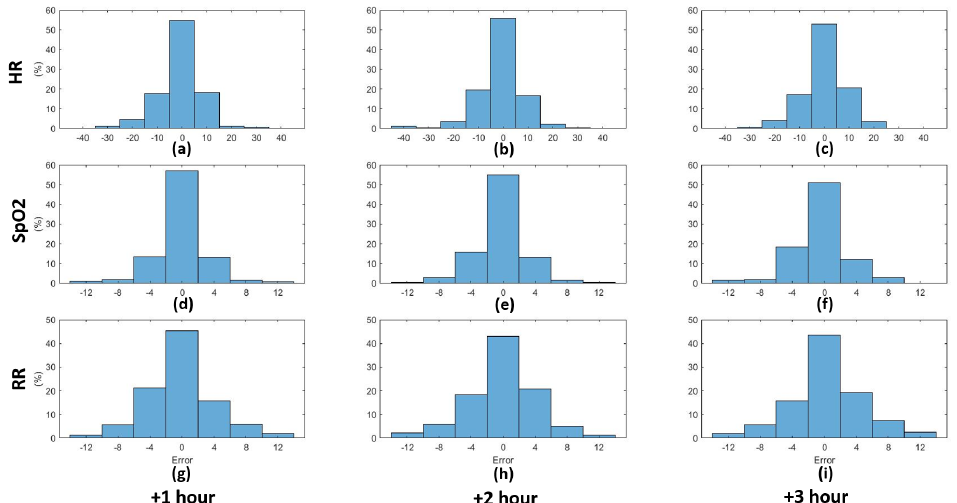
Figure 10. Normalised histograms of the error of the predicted values for the three vital signs for the upcoming three hour based observation rate of one observation/5 min. Each row represents one of the three vital signs: heart rate, oxygen saturation, and respiration rate respectively. Each column represents the prediction hour: +1, +2, +3 h respectively. ( a ) HR +1 h, ( b ) HR +2 h, ( c ) HR +3 h, ( d ) SpO 2 +1 h, ( e ) SpO 2 +2 h, ( f ) SpO 2 +3 h, ( g ) RR +1 h, ( h ) RR +2 h, ( i ) RR +3